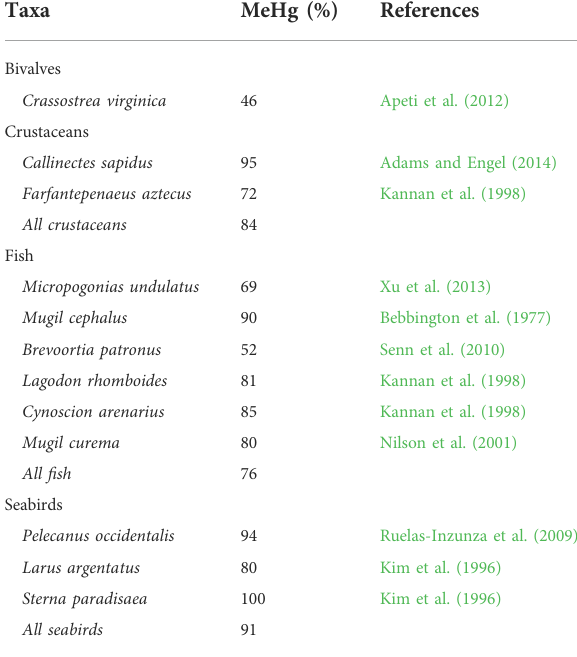
TABLE 1 Taxa-speci fi c literature values of the average percentage of measured total mercury (THg) in dry muscle tissue that is present in the form of Methylmercury (MeHg). The percentages of THg that is MeHg averaged for each consumer type: bivalves (46%), crustaceans (84%), fi sh (76%), and seabirds (91%) were then used to convert all THg concentrations to MeHg